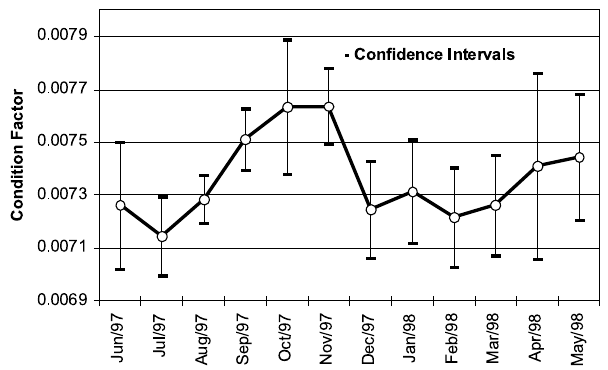
Fig. 4: Monthly average condition factor of females of Menticirrhus littoralis . Animals captured at Cidreira’s fishing pier, Rio Grande do Sul, Brazil, from June 1997 to May 1998.